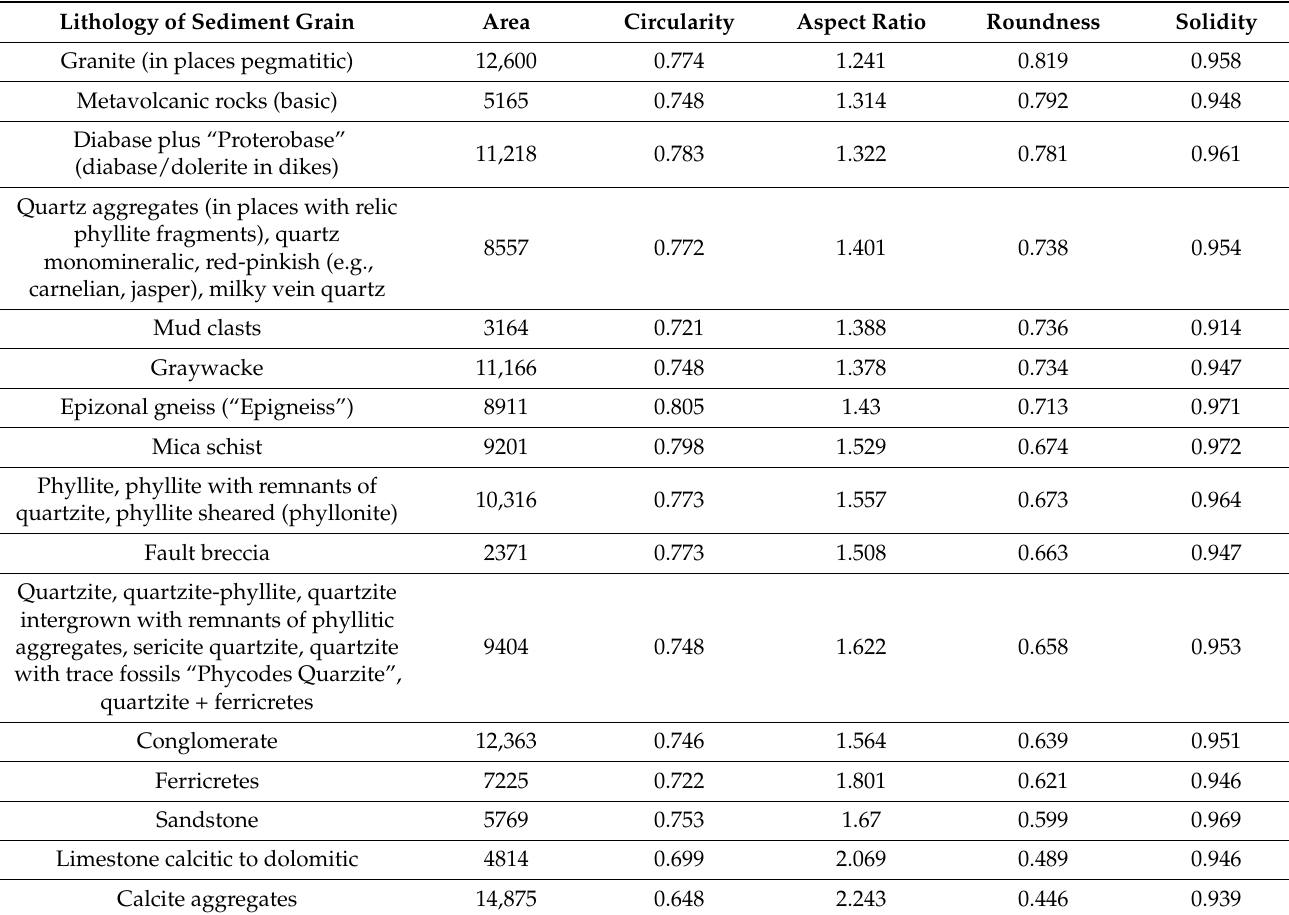
Table 2. Lithology of gravelly debris of the Steinach drainage system and the mean values of different sedimentological parameters measured and calculated from digital image analyses of gravel. For definition and algorithm of area, circularity, aspect ratio, roundness and solidity please see text (Section 4.3.3, Digital image